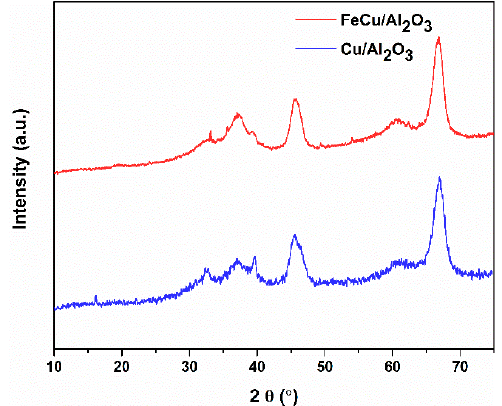
Figure 2. XRD patterns of the γ -Al 2 O 3 -supported catalysts.